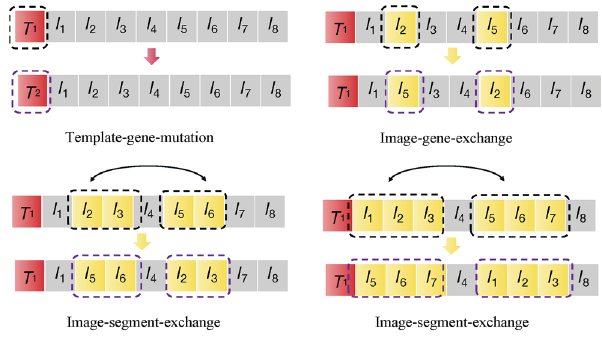
Fig. 4 Mechanism of genetic